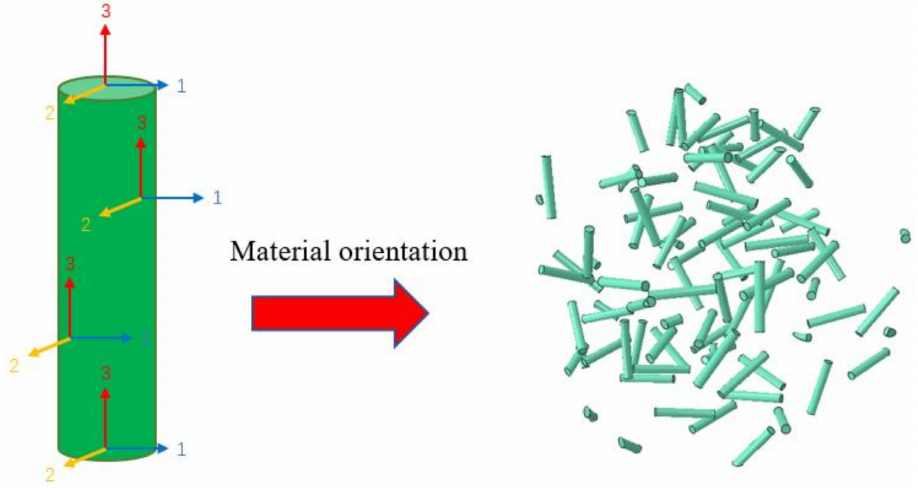
Figure 9. Material orientation of